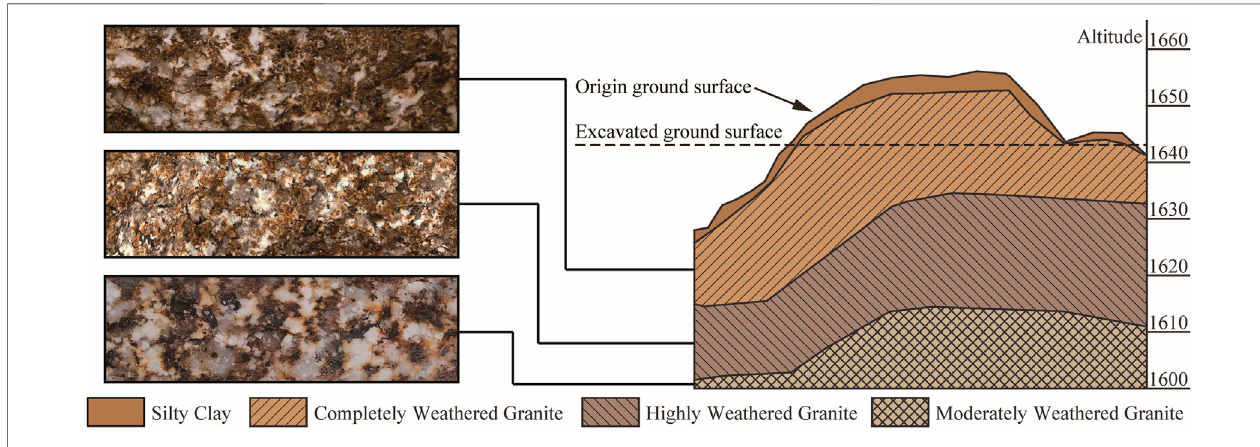
FIGURE 1 | Stratigraphic sections of the research